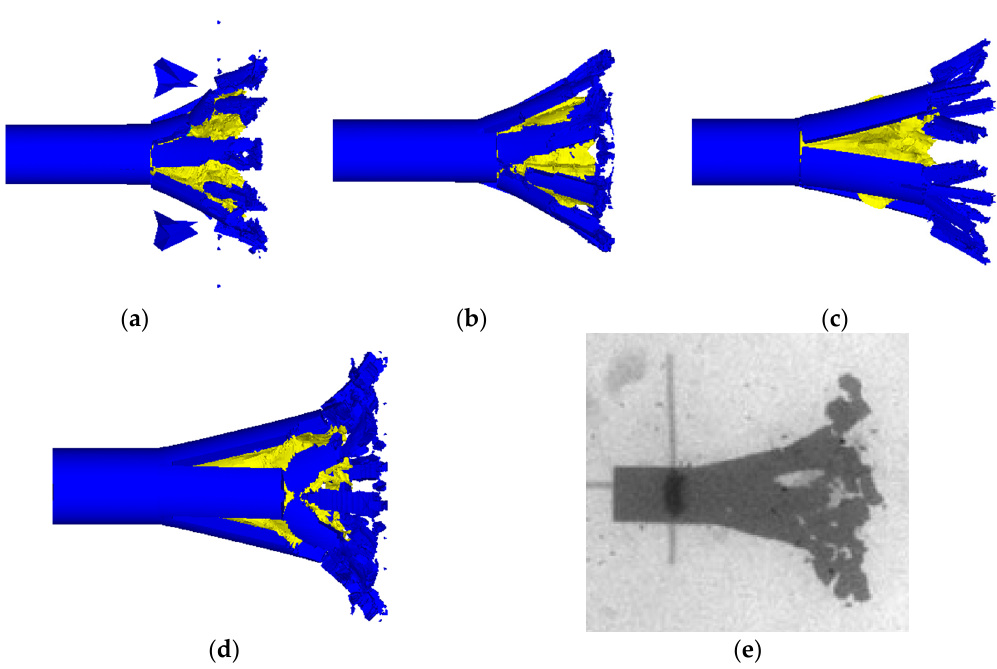
Figure 13. Comparison of the test results and simulation results of different failure models: ( a ) no crack softening, ( b ) no stochastic failure, ( c ) no crack softening and no stochastic failure, ( d ) crack softening and stochastic failure, and ( e ) X-ray experiment picture.